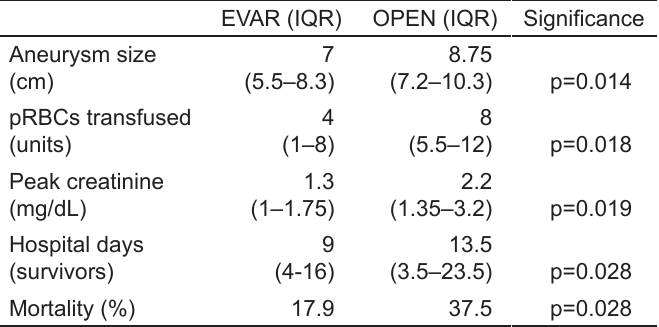
Table 1. Comparison of endovascular and open repair.